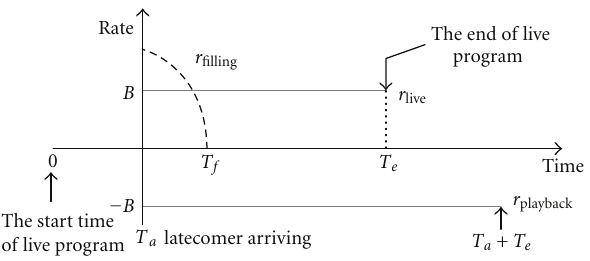
Figure 9: A media rate diagram of a client on LHB.